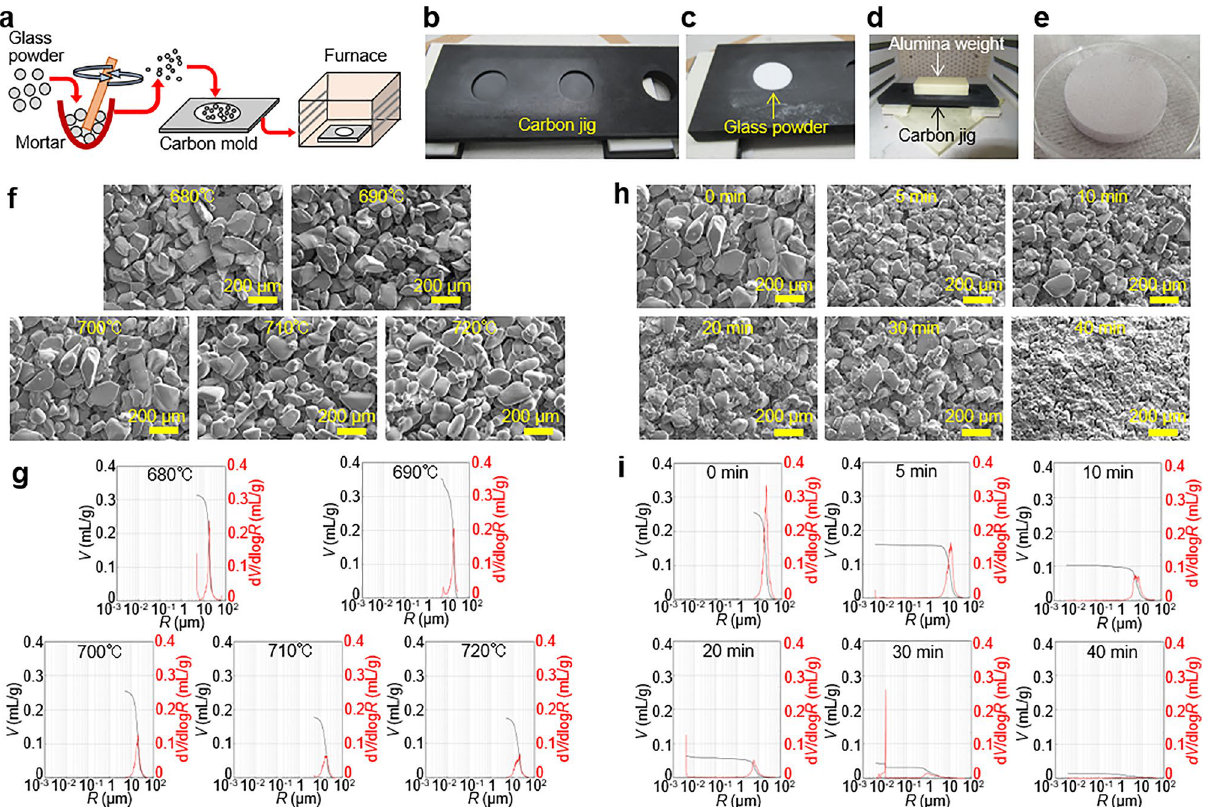
Figure 2. Fabrication and structure investigation of porous glass filters. ( a ) Fabrication procedure of glass filters. ( b ) Carbon mold to fabricate glass filters. ( c ) A hole in the mold is filled with glass powder. ( d ) Setup in a furnace with an alumina weight. ( e ) Fabricated glass filter. ( f ) SEM images of porous glass filter surfaces after sintering at the temperature indicated at the top of each image. ( g ) Results of mercury porosimetry of the porous glass filters sintered at various temperatures. Black and red lines indicate pore volume per mass ( V ) and pore radius ( R ) distribution (derivation of V by R ), respectively. ( h ) SEM images of the porous glass filter surfaces sintered at 700 °C using ground glass powder and the milling time indicated at the top of each image. ( i ) Results of mercury porosimetry of the porous glass filters sintered at 700 °C using ground glass powder and the milling time indicated at the top of each image. Scale bars are shown in SEM images of ( f ) and ( h